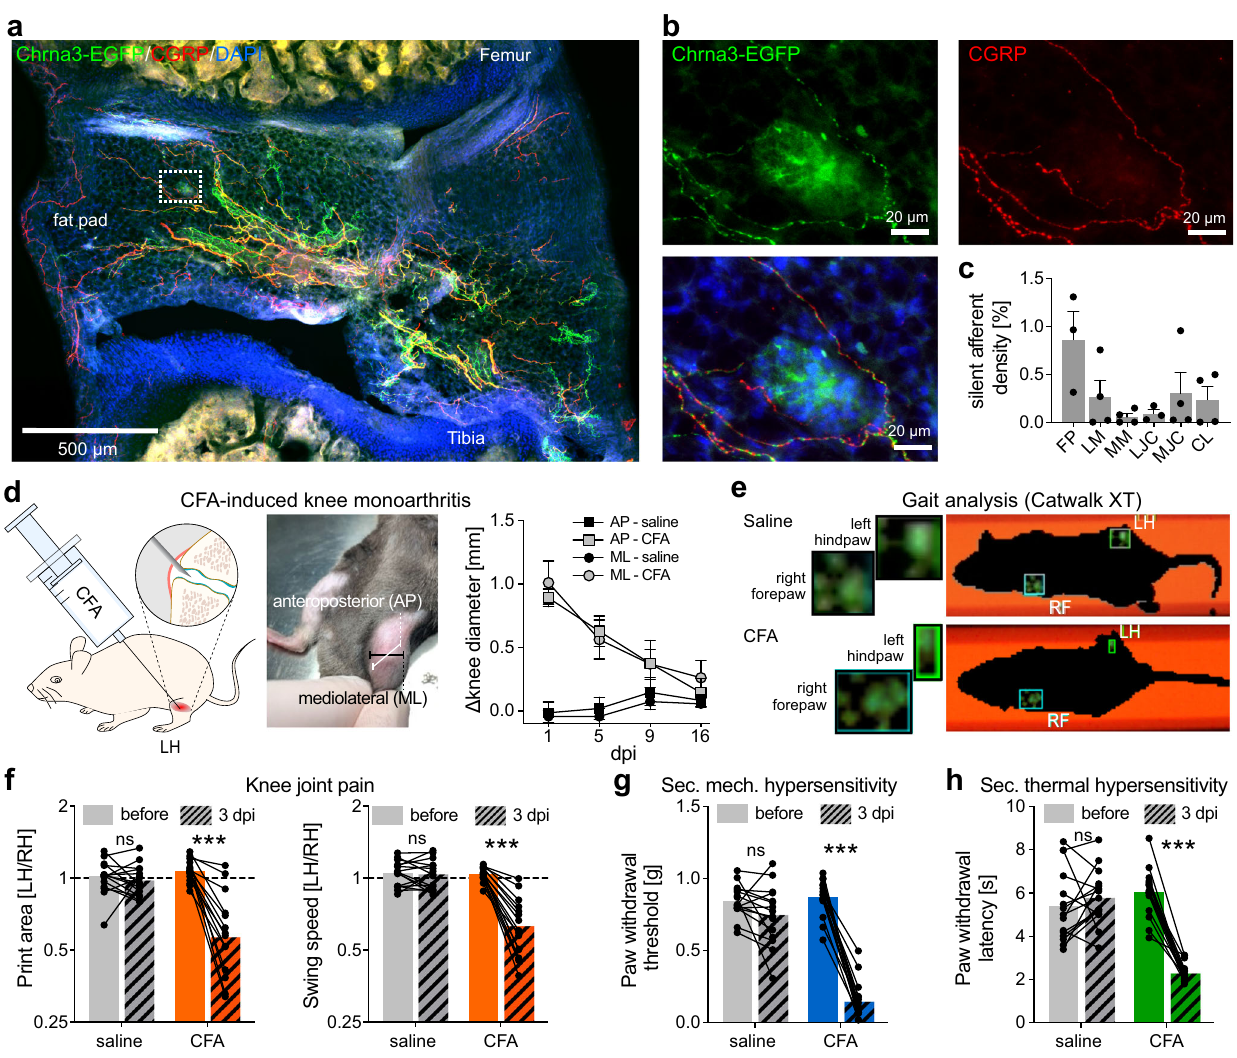
Fig. 2 | Intraarticular CFA injection induces knee joint pain and secondary mechanical hypersensitivity in the hind paw. a Representative image of a knee joint section immunostained for CGRP and EGFP. Note, only EGFP + fi bers that co- express CGRP are sensory afferents. CGRP – /EGFP + fi bers are sympathetic efferents (see Prato et al., 2017). b Close-up of the region marked by the white rectangle in a ,emphasizing co-expressionofEGFPand CGRP. c Quanti fi cationofsilentafferent density (EGFP + /CGRP + fi bers) in anatomically de fi ned regions. FP (Hoffa ’ s fat pad), LM (lateral meniscus), MM (medial meniscus), LJC (lateral joint capsule), MJC (medial joint capsule), CL (cruciate ligament). Bars represent means±SEM from three different mice. For each mouse, at least three photomicrographs per anato- mical region were analyzed and averaged. Means from each mouse are shown as blackdots. d Cartoondepictingtheexperimentalapproach(left),photographofan in fl amed knee (middle) and time course (days post-injection, dpi) of saline- ( n =5 mice)andCFA-induced( n =6mice)changesinkneesize(right).Dataarepresented